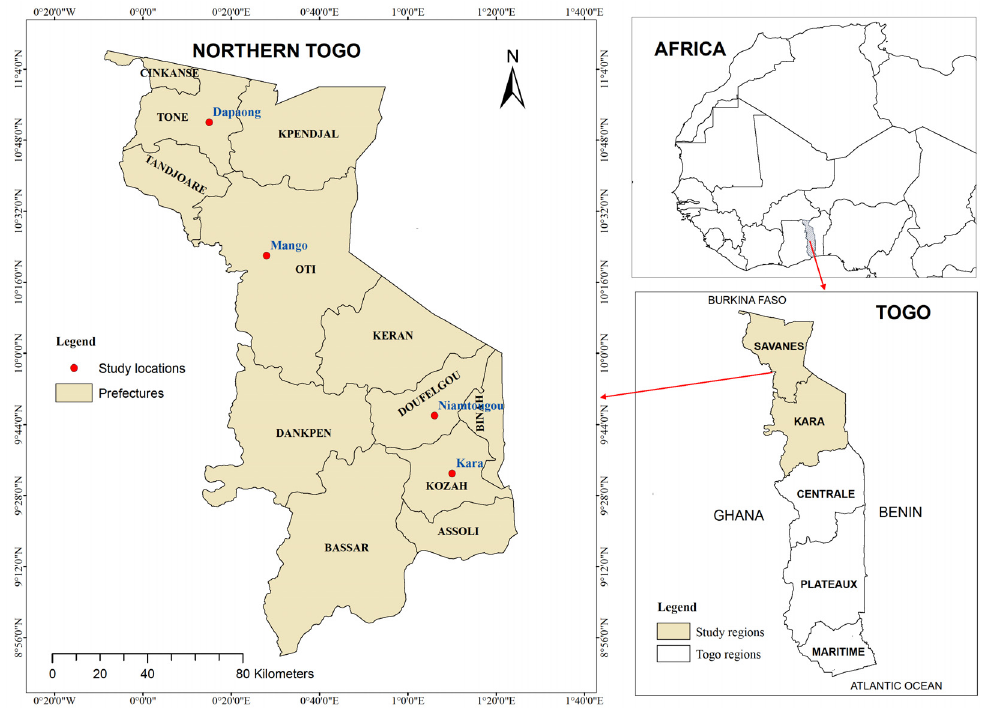
Figure 1. Map of the study sites (northern